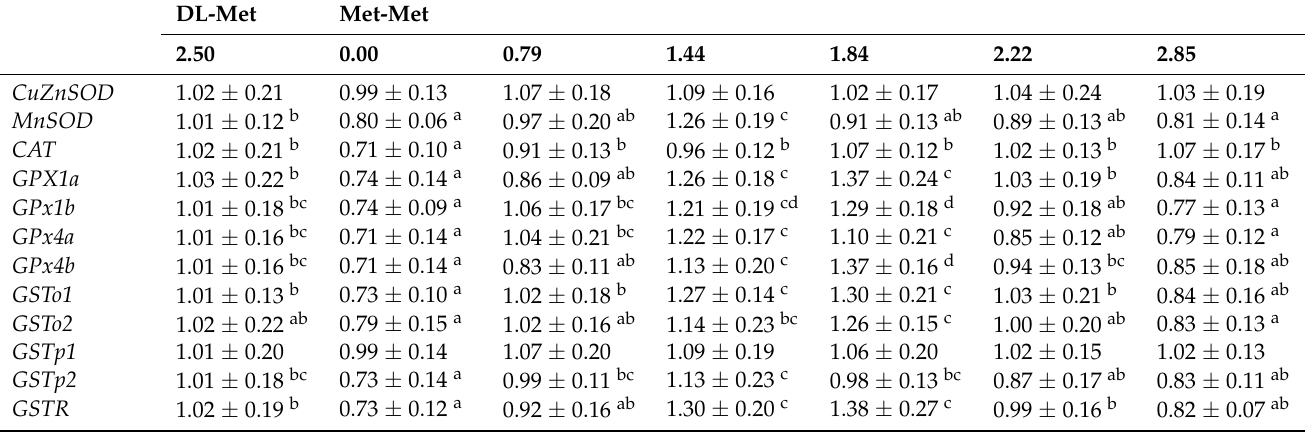
Table 5. Effects of dietary DL-Met and Met-Met supplementation (g/kg diet) on relative gene expressions of antioxidant enzymes and Nrf2 signaling in the mid intestine of juvenile grass